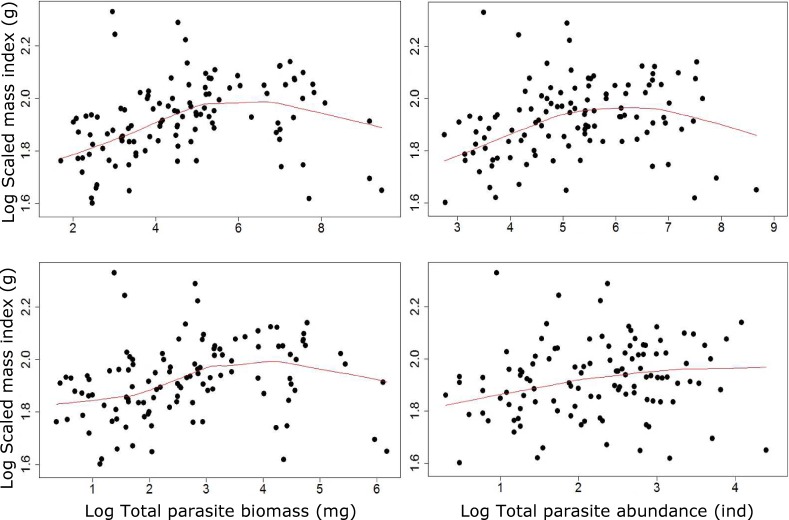
Relationships between scaled mass index (SMI, g) and total abundance (right) or biomass (left) of all six parasite taxa combined with (up) and without (down) the most abundant parasite taxa (Apatemon sp.) in common bullies (Gobiomorphus cotidianus).Lowess fitted curves are included on each graph.